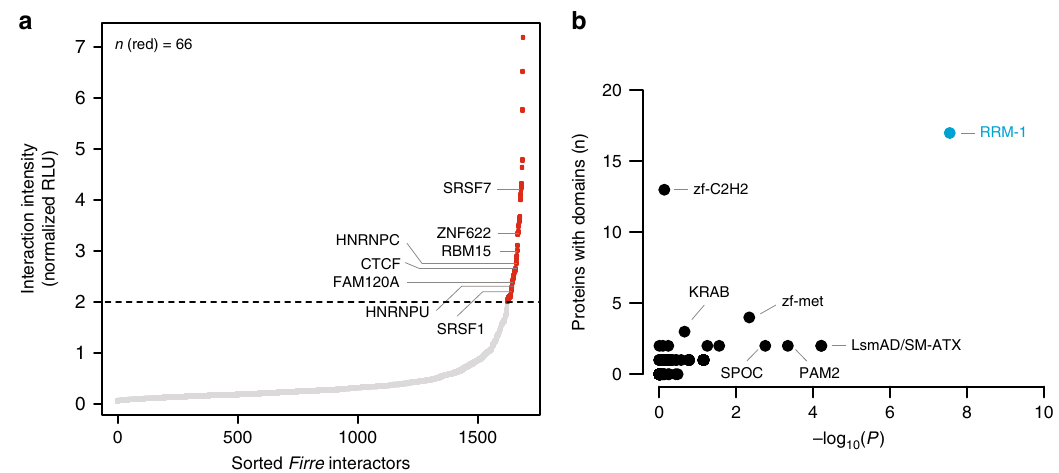
Fig. 3 incPRINT identi fi es Firre – interacting proteins. a Normalized Firre- protein interaction intensities averaged from two biological replicates, sorted in increasing order. The horizontal dotted line represents interaction intensity cutoff used for the classi fi cation of Firre interactors. Red dots are Firre- interacting proteins; gray dots are proteins that do not bind to Firre . Proteins either known to bind to Firre or those whose interaction was validated in ENCODE eCLIP data 21 are indicated. See the ‘ Methods ’ section for data normalization. RLU are relative light units. b Plot showing the number of incPRINT Firre -interacting partners that contain a particular Pfam domain vs. the − log P ) of the domain ’ s enrichment. P values were calculated using the proportion 10 ( test. Shown in blue are domains represented at least three times in the pulled-down fraction that have a corrected P < 0.05. RRM-1 refers to the Pfam domain PF00076. For all analyzed Pfam domains, see Supplementary Data